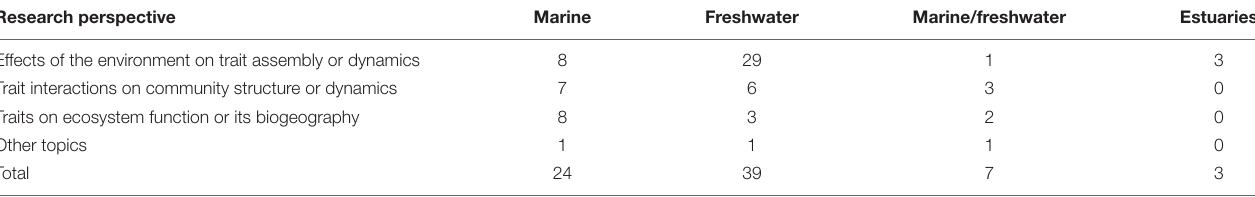
TABLE 1 | Summary of the focus of the 73 trait-based studies examining entire (or a majority of groups within) phytoplankton communities. Research